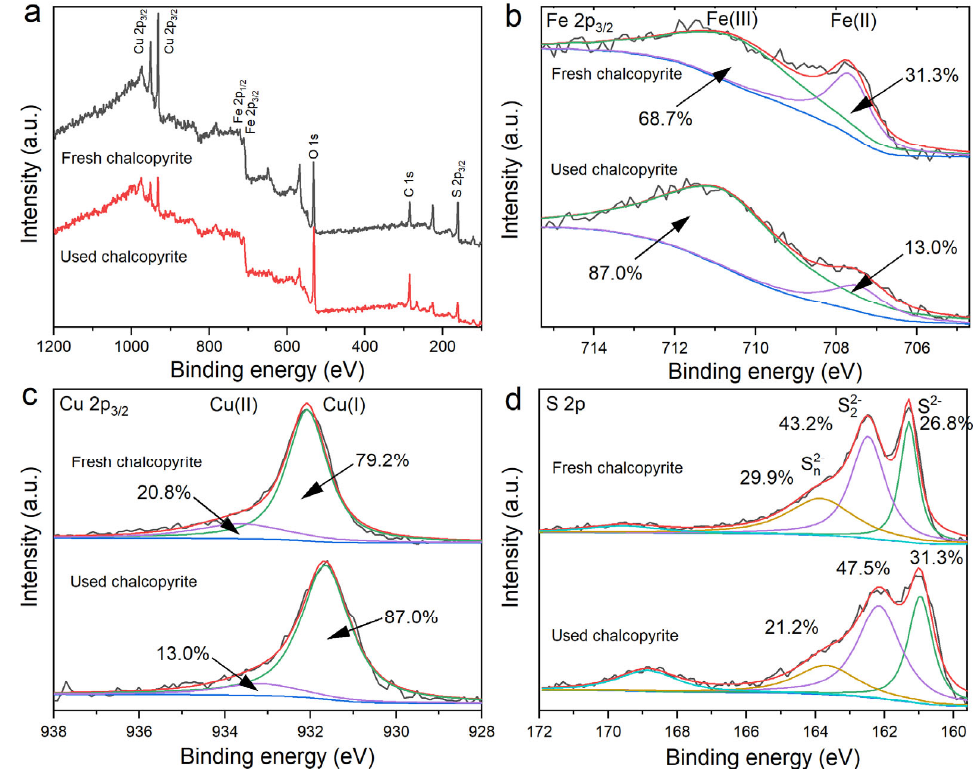
Figure 5. XPS spectra of fresh and used chalcopyrite: ( a ) survey spectra, ( b ) Fe 2p 3/2 , ( c ) Cu 2p 3/2 , and ( d ) S 2p.